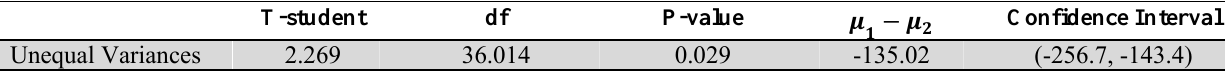
T-student Confidence Interval Unequal